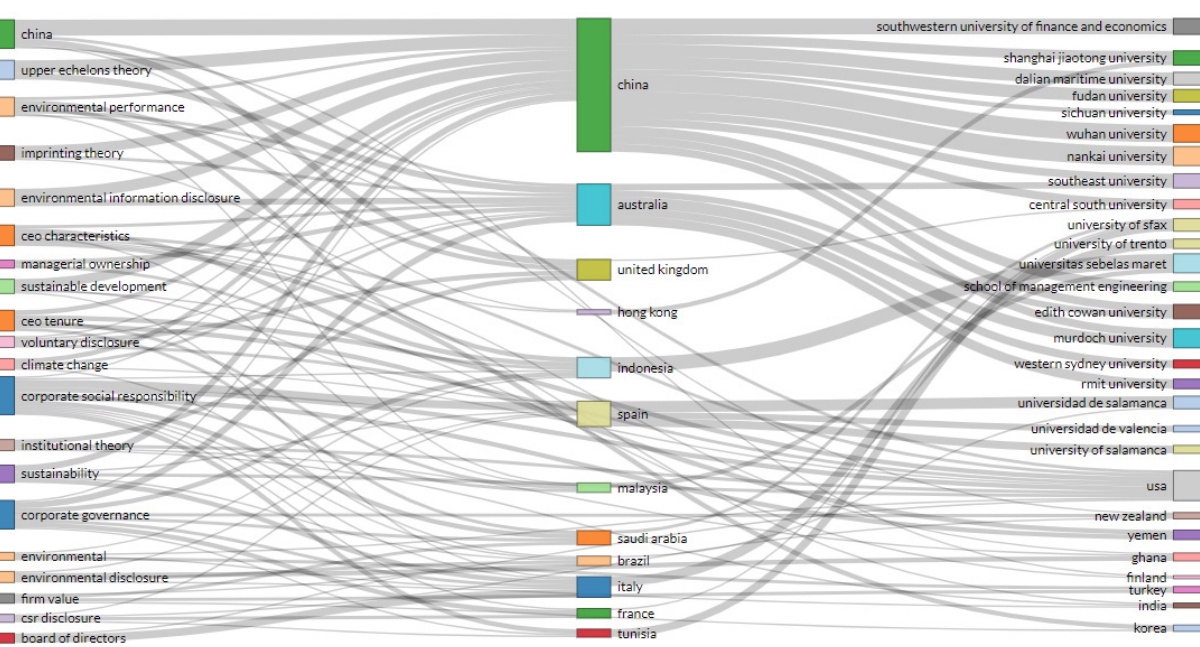
Figure 3. Three-field analysis of TMT characteristics and environmental disclosure literature.